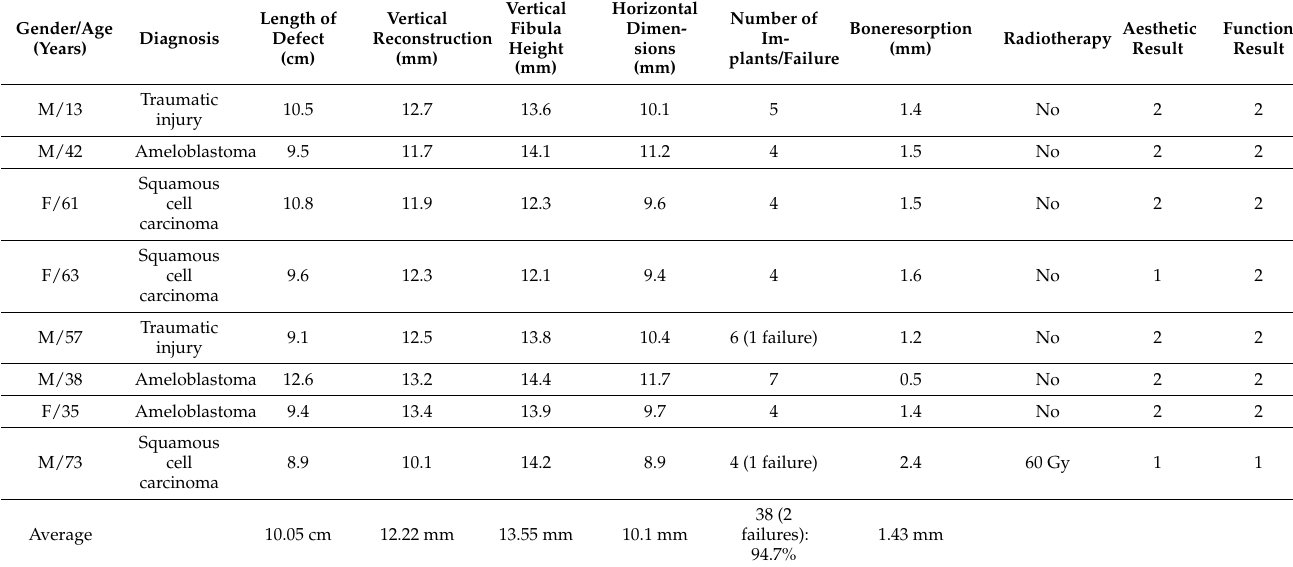
Table 1. Fibula reconstruction with iliac crest bone graft through VSP and CAD/CAM titanium